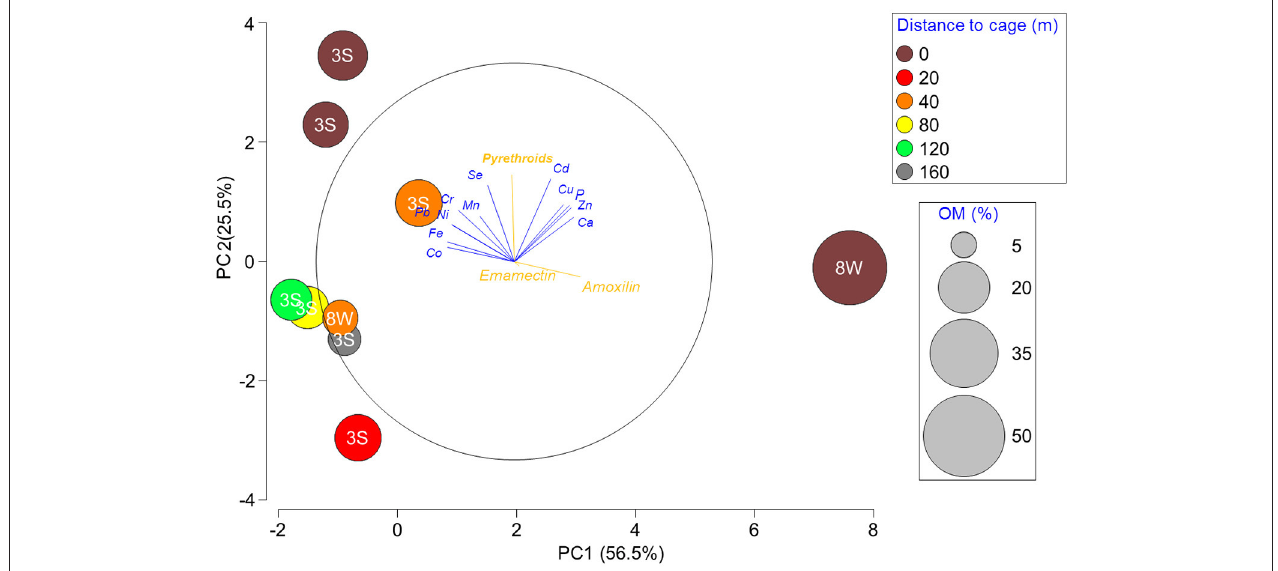
TABLE 3 | PERMANOVA on data from all chemical analyses combined after log x + 1 transformation, and matrix of similarity based on Euclidian distance. Source DF Mean squares Pseudo-F P (perm) Number of permutations P (MC) Estimate of variation (Sq.root) OM 1 12.991 16.057 0.0359 1,355 0.025 1.5626 Distance 5 4.738 5.8562 0.1424 84,405 0.0624 1.7952 Residuals 2 0.80906 0.89948 Total 8 Model was run using 99,999 permutations. DF, degrees of freedom; Sq.root, square root; MC, Monte-Carlo p test. Bold values denote statistical significance at P < 0.05